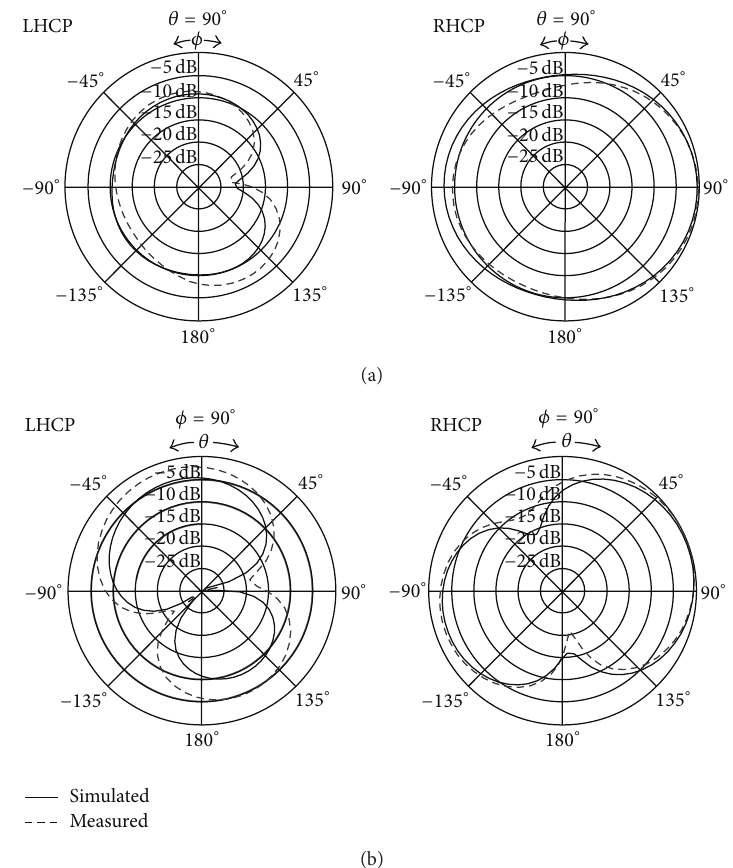
Figure 4: Radiation patterns at 925 MHz. (a) x-y plane and (b) y-z